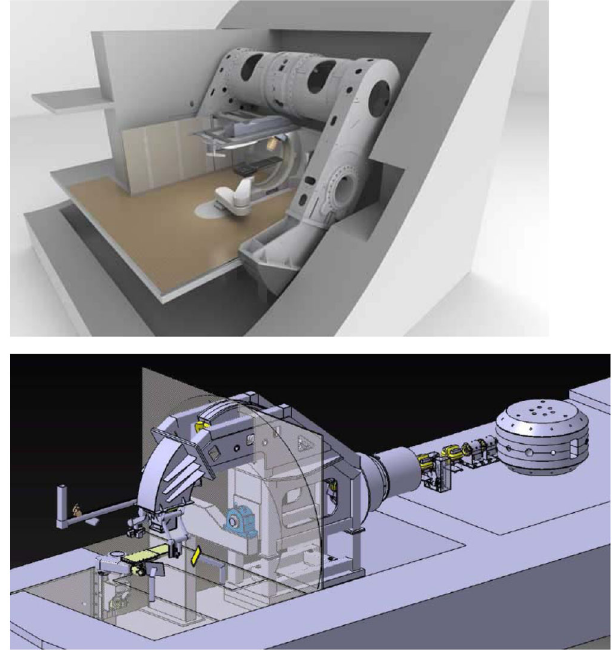
FIG. 2. Two examples of commercial single-room proton therapy facilities. Top: Mevion S250 ™ , Mevion, Littleton, MA, USA. Building volume approximately 14 × 14 × 14 m 3 (data from [7]). Bottom: ProteusOne ™ Ion Beam Applications, Louvain-la-Neuve, Belgium. Building volume approximately 13 × 14 × 27 m 3 (data from